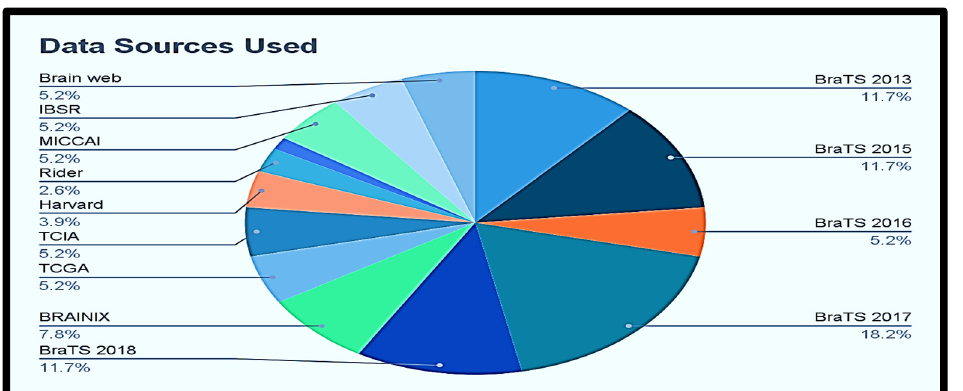
Figure 2. Pictorial representation of online data sources most frequently used by world-wide re- searchers.